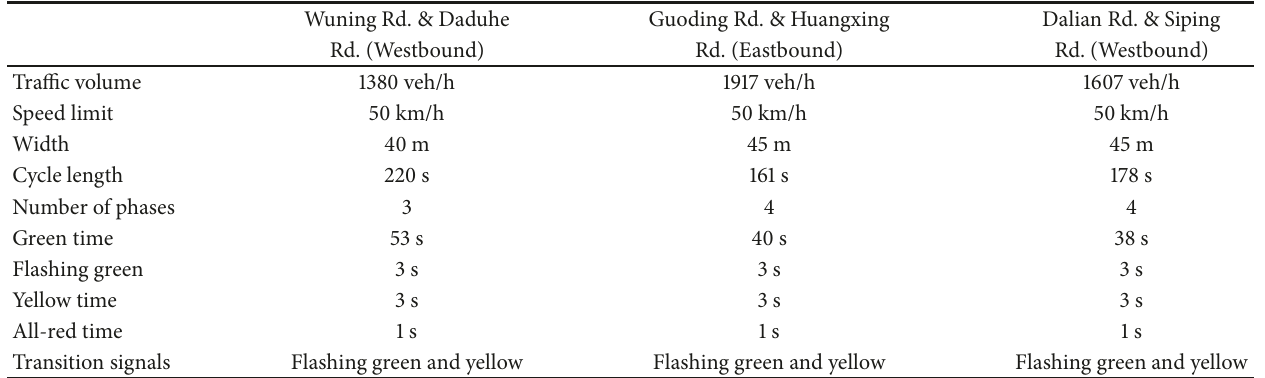
Table 1: Characteristics of the studied intersections in